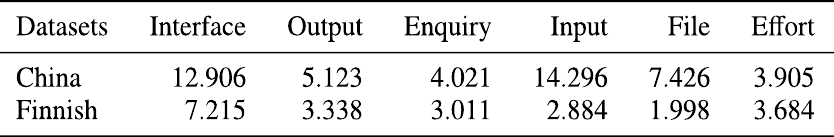
Table 2. Pearson’s moment coefficient of